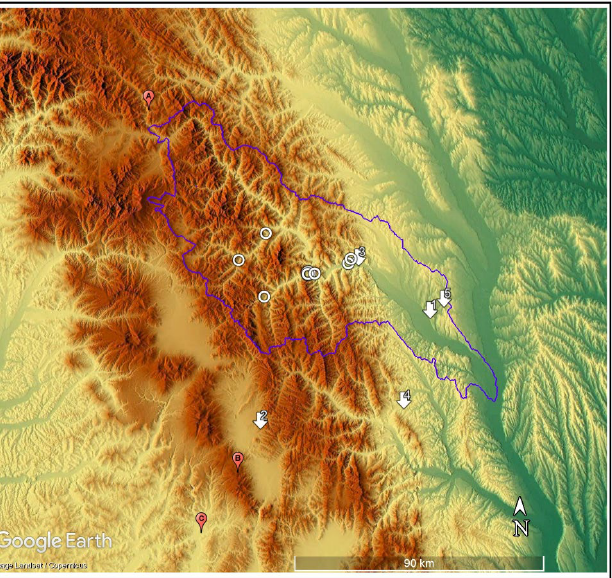
Figure 17. Map of the settlements (white arrows) with miniature vessels ( 1. Costișa — Cetățuia ; 2. Păuleni — Dâmbul Cetății ; 3. Piatra Neamț — Bâtca Doamnei ; 4. Poduri— Dealul Ghindaru ; 5. Siliștea — Pe Cetățuie ), metal finds from the area of interest (white circle) and the current sources of ocher exploitation (A. Iacobeni; B. Sîntimbru- Băi; C. Baraolt) .